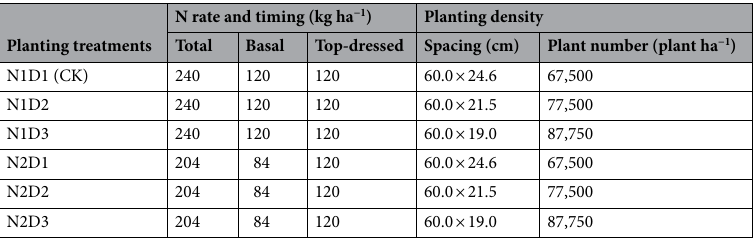
Table 6. N fertilization application and planting density for each planting